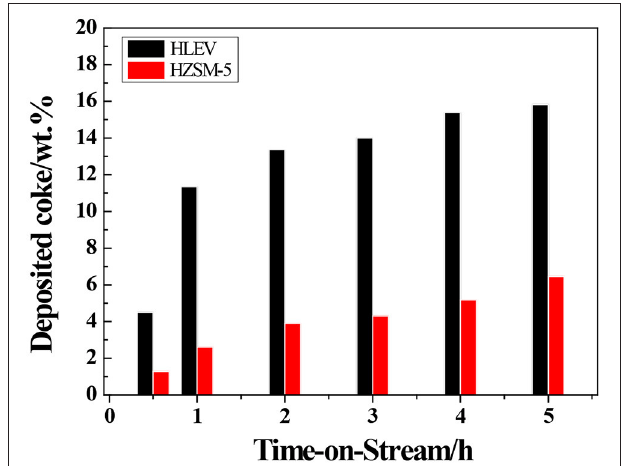
FIGURE 3 | Evolution of coke deposited over H-ZSM-5 (40) and H-LEV (40) with time on stream. Reaction conditions: 673K, 0.1 MPa, W/F = 0.05 g.min.mL − 1 .